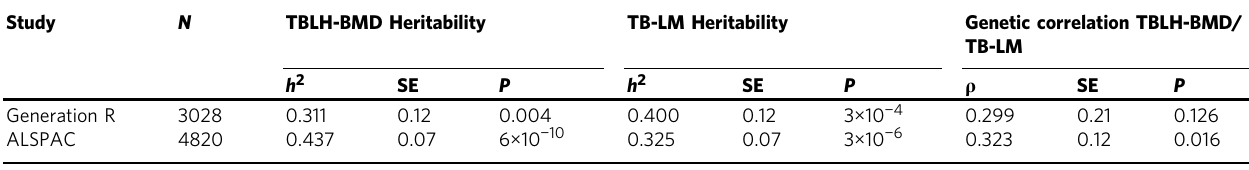
Table 2 Trait SNP heritability and genetic correlation TBLH-BMD/TB-LM in pediatric populations